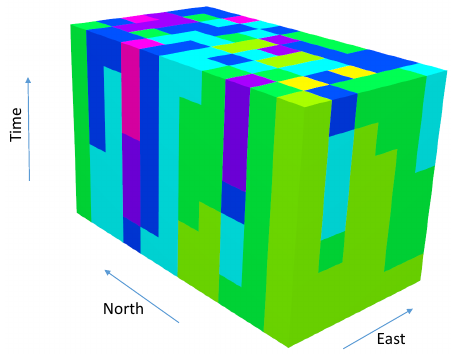
Figure 1. Graphical depiction of a hypothetical 3-D cuboid U rep- resenting land use in space and time dimensions. Different colours show different land